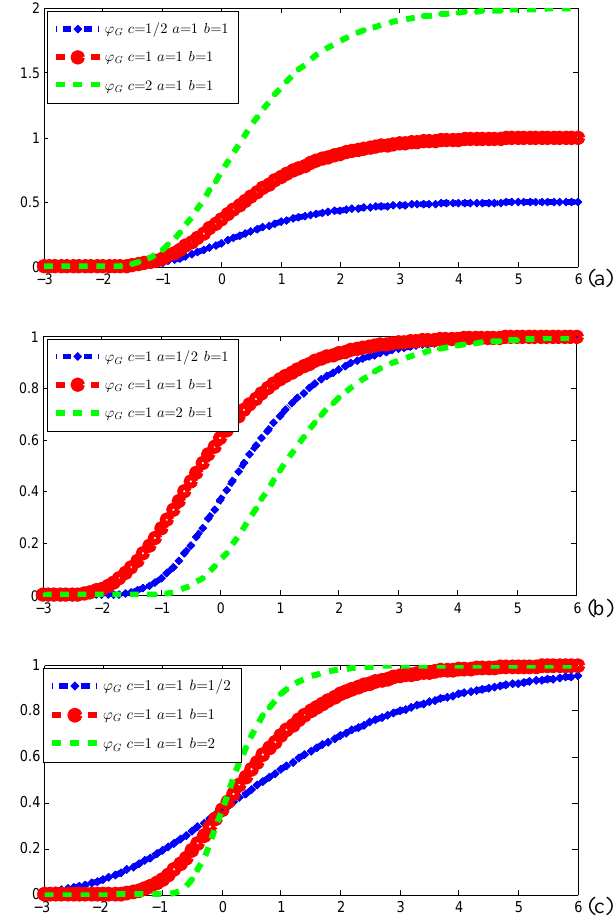
Fig. 1. Illustration of Gompertz function: (a) c varies with fixed a and b , (b) a varies with fixed b and c and (c) b varies with fixed a and c